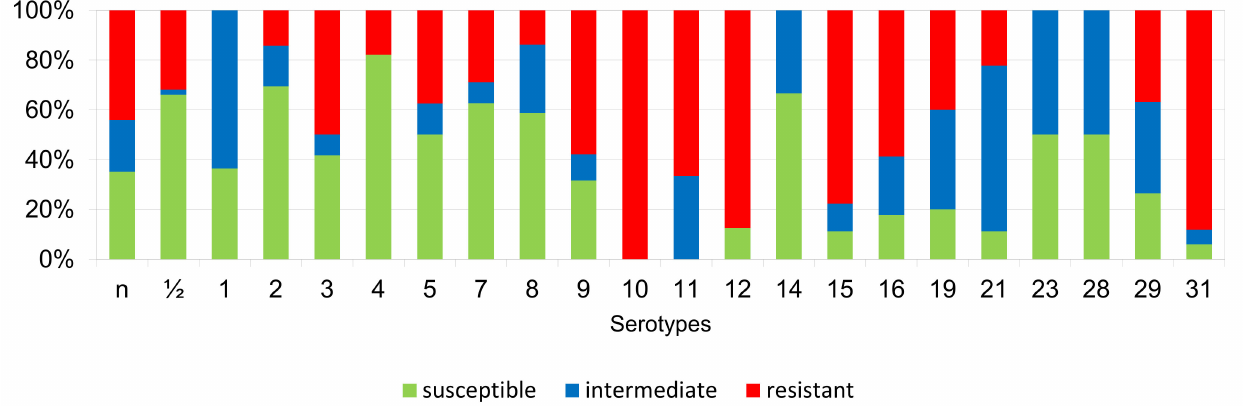
Figure 10. Percentage representation of isolates resistant, intermediately resistant, and susceptible to tiamulin belonging to individual S. suis serotypes from the Czech Republic during 2018–2022 ( n = 506). n = non-typeable isolates.